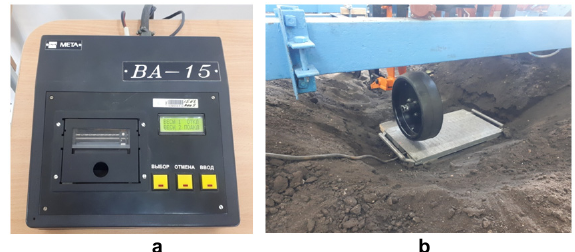
Figure 11. Strain gauge